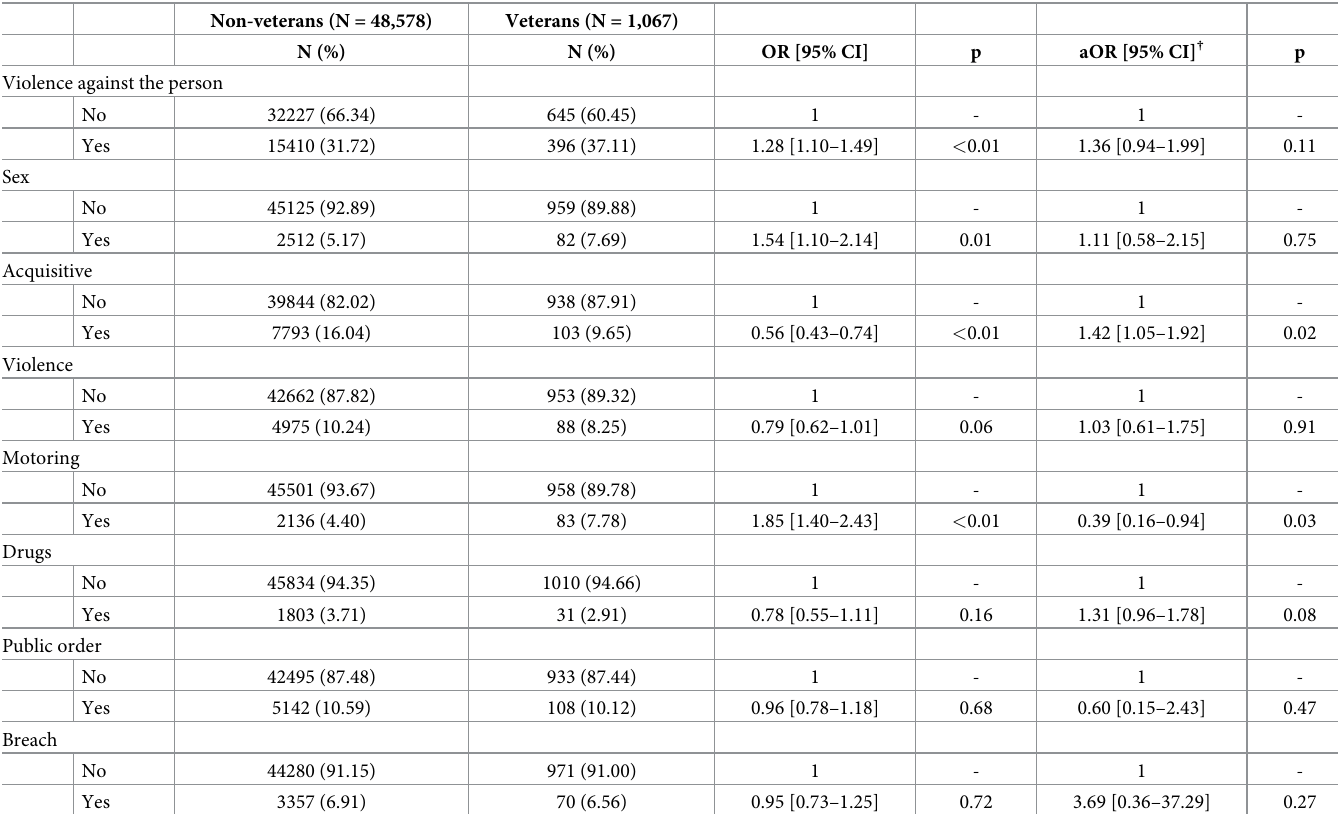
Table 2. Association of offence type with veteran